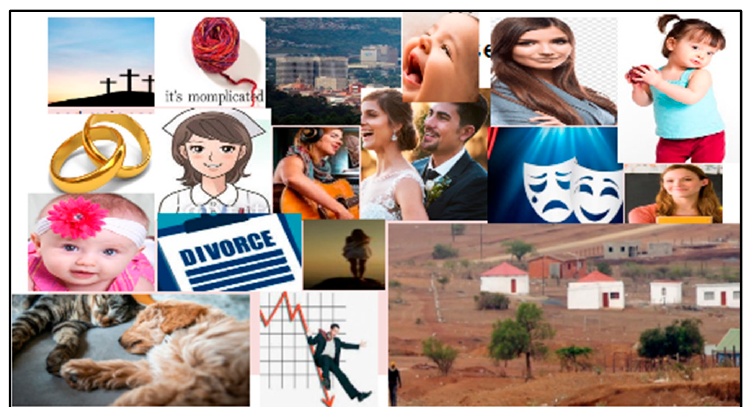
Figure 11. Adulthood in Diana’s timeline.